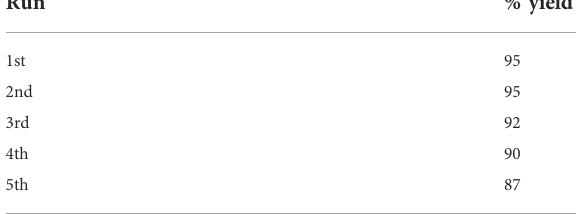
TABLE 3 Number of reusability of the catalyst for the synthesis of compound 7a.